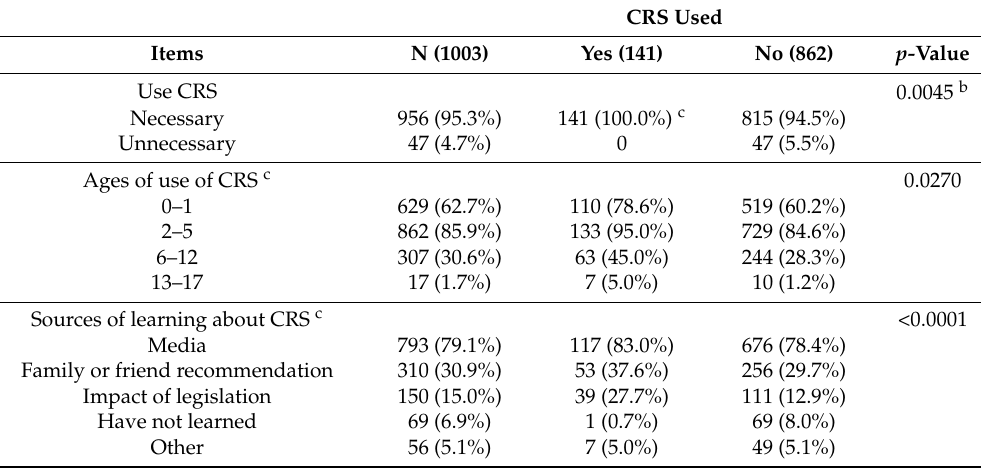
Table 2. Attitudes and knowledge on CRS of surveyed drivers a